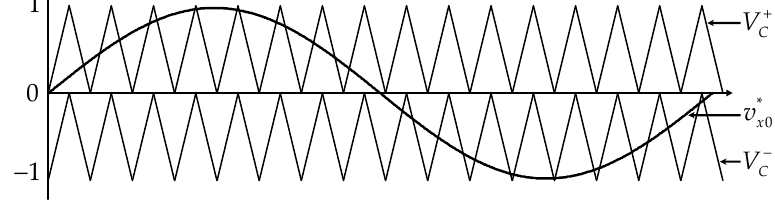
Figure 2. The normalized pole voltage reference and the carrier signals.